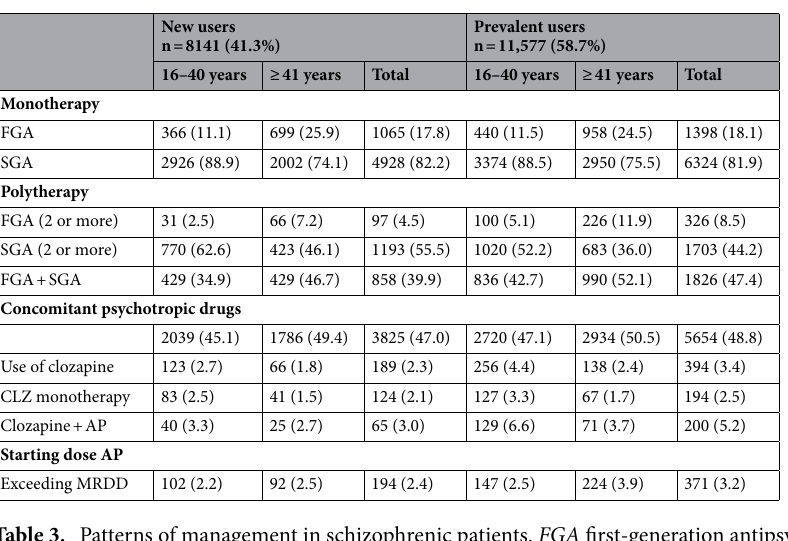
Table 3. Patterns of management in schizophrenic patients. FGA first-generation antipsychotic, SGA second- generation antipsychotic, CLZ clozapine, AP antipsychotic, MRDD maximum recommended daily doses.